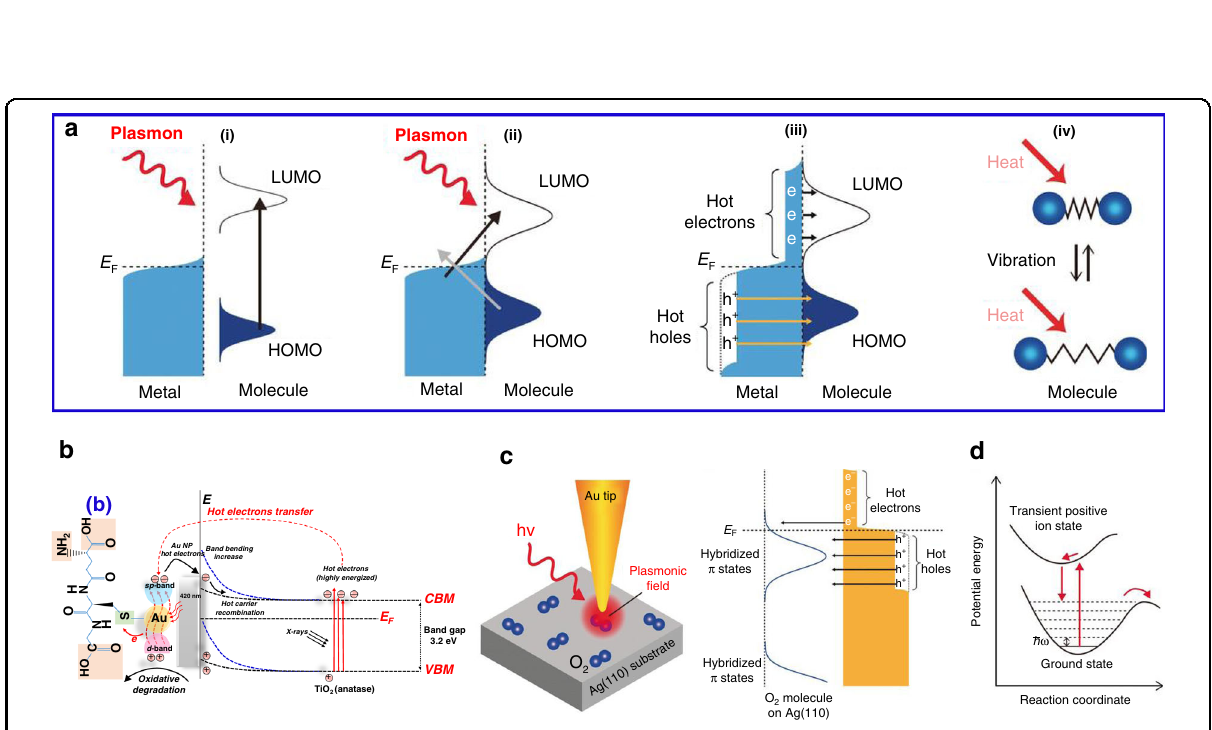
Fig. 18 Schematics of the surface plasmon-mediated chemical reactions with the HC before thermalization. a The excitation mechanisms in plasmonic-induced reactions representing (i) direct intramolecular excitation, (ii) excitation between metal and adsorbate, (iii) HC transfer to adsorbate, and (iv) local heat generation through the decay of localized surface plasmons that cause vibrational excitation. b The interfacial chemistry and charge transfer mechanism of thiolated Au/TiO 2 excited through X-rays and visible light radiations. c Illustration of the experimental setup and plasmon-induced disassociation of a single O 2 molecule when it adsorbed on Ag surface and d HC transferred to hybridized π * states of O 2 molecule and potential energy curve for O 2 molecular dissociation. The Figures are taken with permission from ( a , c , d ) ref. 106 and ( b ) ref.